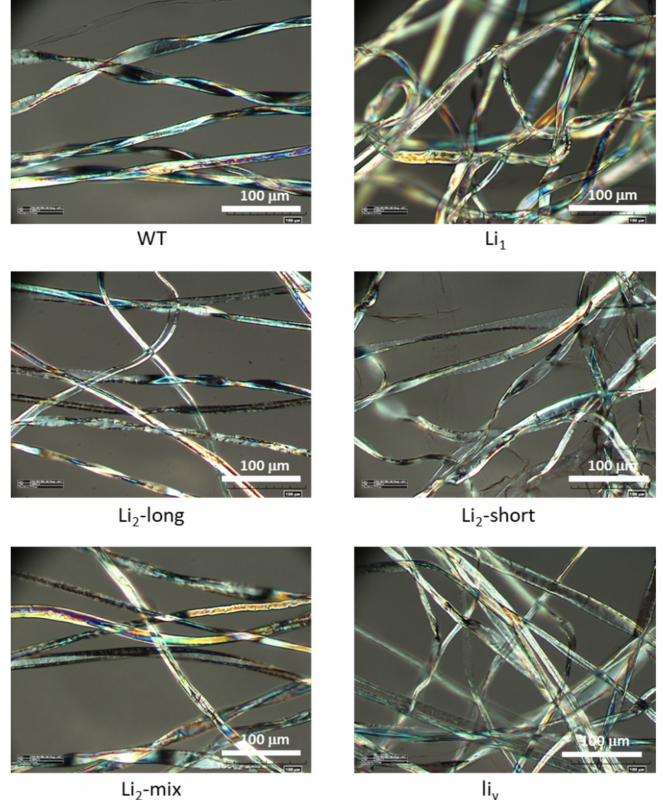
Figure 3. Morphologies of cotton fibers visualized by polarized optical